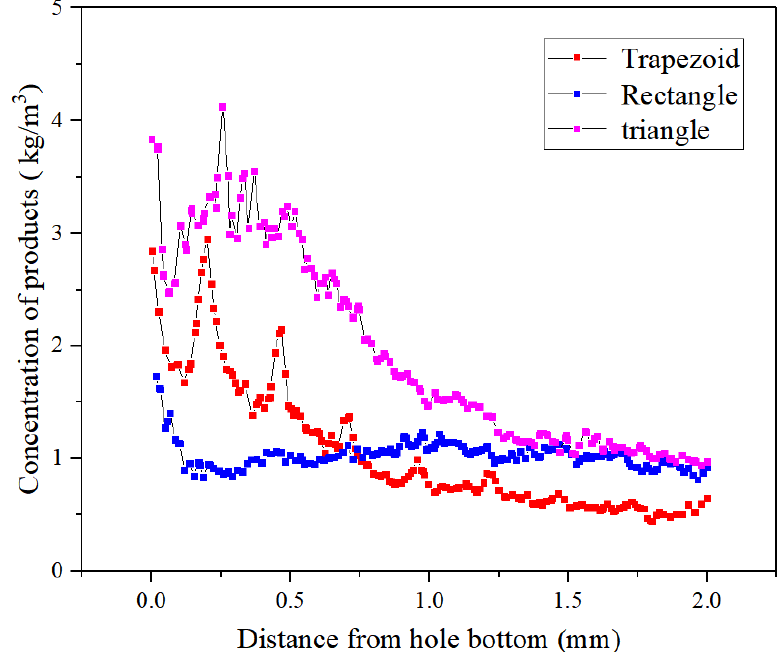
Figure 6. Concentration distributions of the processed products in the side machining gaps using di ff erent helical electrodes.